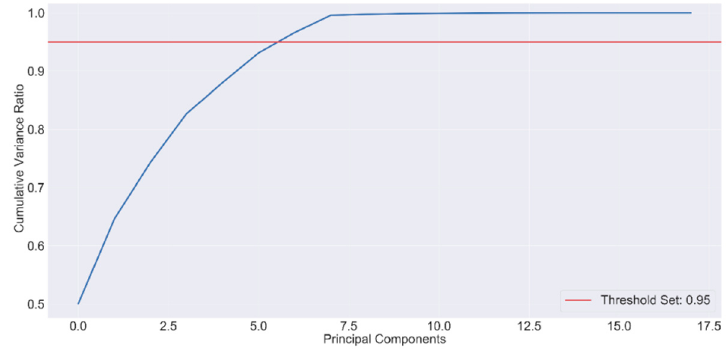
Figure 7. Criteria used for cluster assessment.